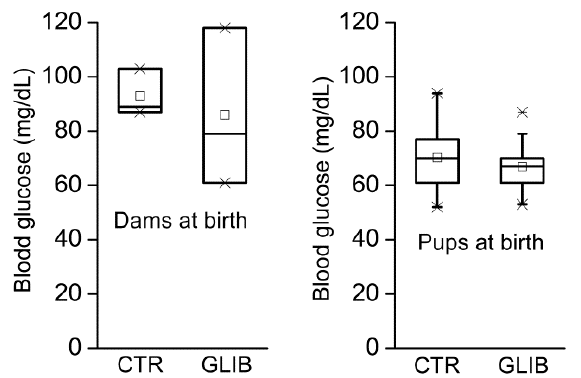
Figure 4. Prenatal low dose glibenclamide infusion does not lower serum glucose. ( A ) values of serum glucose in control dams (CTR) and dams administered low-dose glibenclamide infusion for 2 days (GLIB); 6 dams per group. ( B ) values of serum glucose in control pups (CTR) and pups whose mother had been administered low-dose glibenclamide infusion for 2 days (GLIB); 11 or 13 pups per group; all measurements made shortly after birth. Box plots: large box, 25th and 75th percentiles; whiskers, 5th and 95th percentile; × , 1st and 99th percentiles; -, max and min; horizontal line, median; small square,